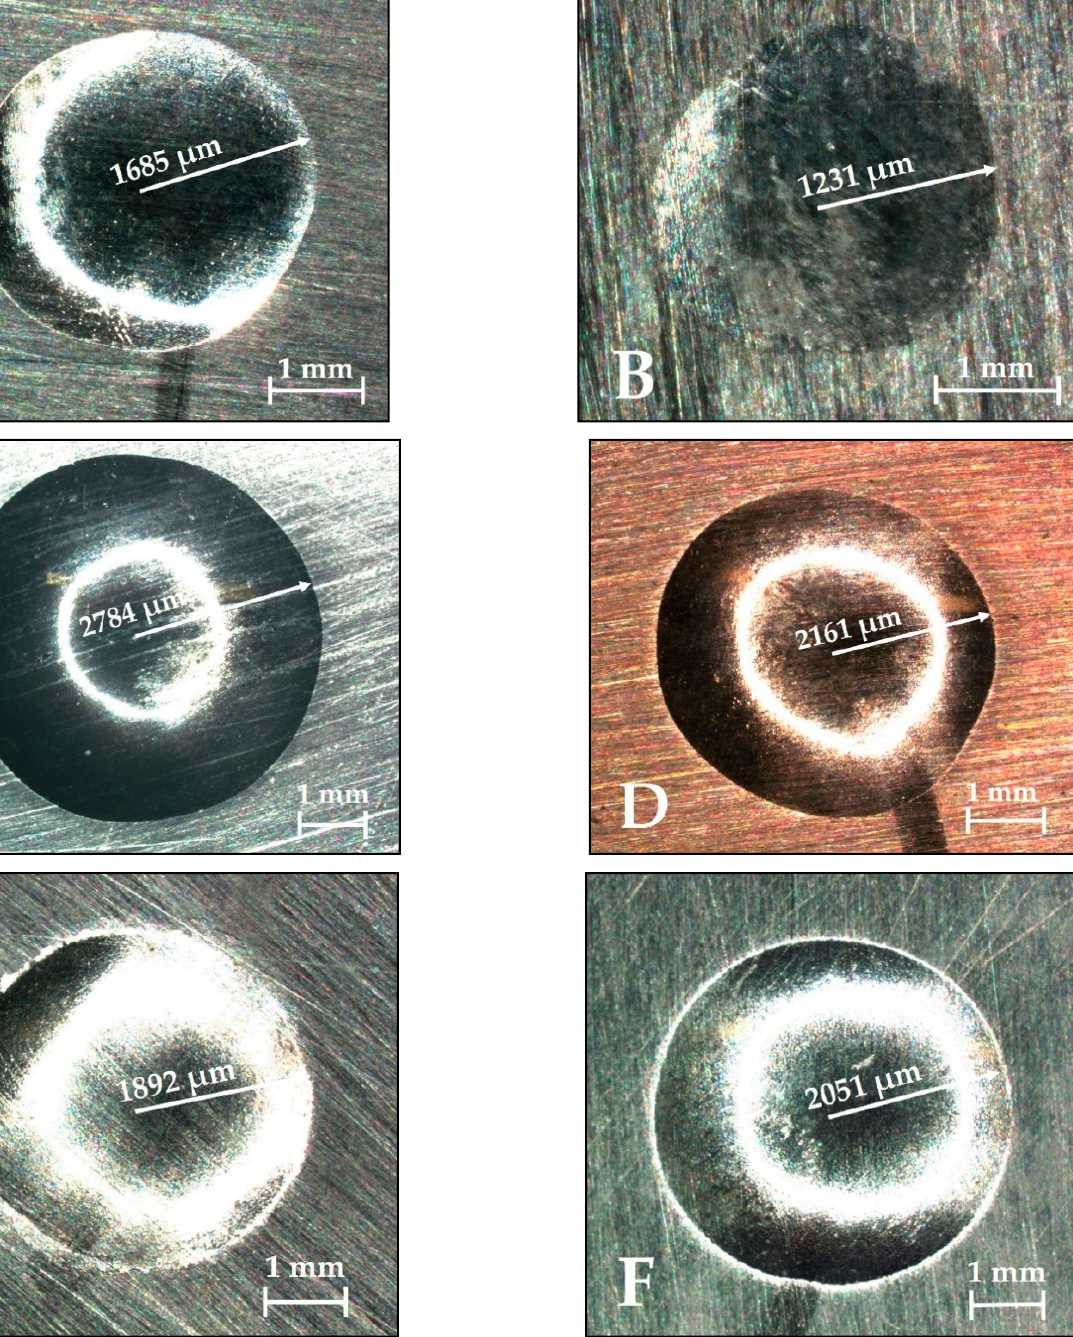
Figure 5. Optical images of the deformation sites (dimples) after impact tests: ( A ) Fe-based 316L, ( B ) Ti-based Ti 6 Al 4 V, ( C ) Al-based AlSi 10 Mg, ( D ) Cu-based CuNi 2 SiCr, ( E ) Co-based CoCr 28 Mo 6 , and ( F ) Ni-based Inconel718 samples. Samples had 20 mm diameter and 10 mm height.